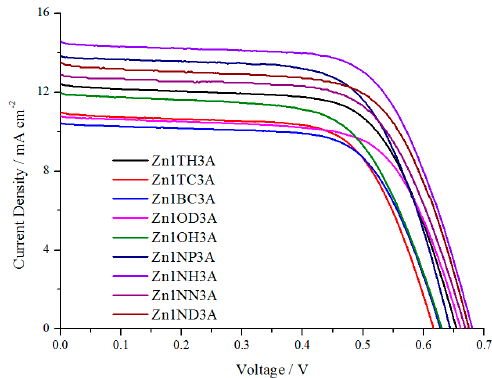
Figure 5. I ‐ V curves for 1D ‐π‐ 3A porphyrin sensitizers. Figure 5. I - V curves for 1D- π -3A porphyrin sensitizers. Table 2. Photovoltaic characteristics of dye sensitized solar cells (DSSCs) incorporating the 1D- π -3A porphyrin dyes. FF : fill